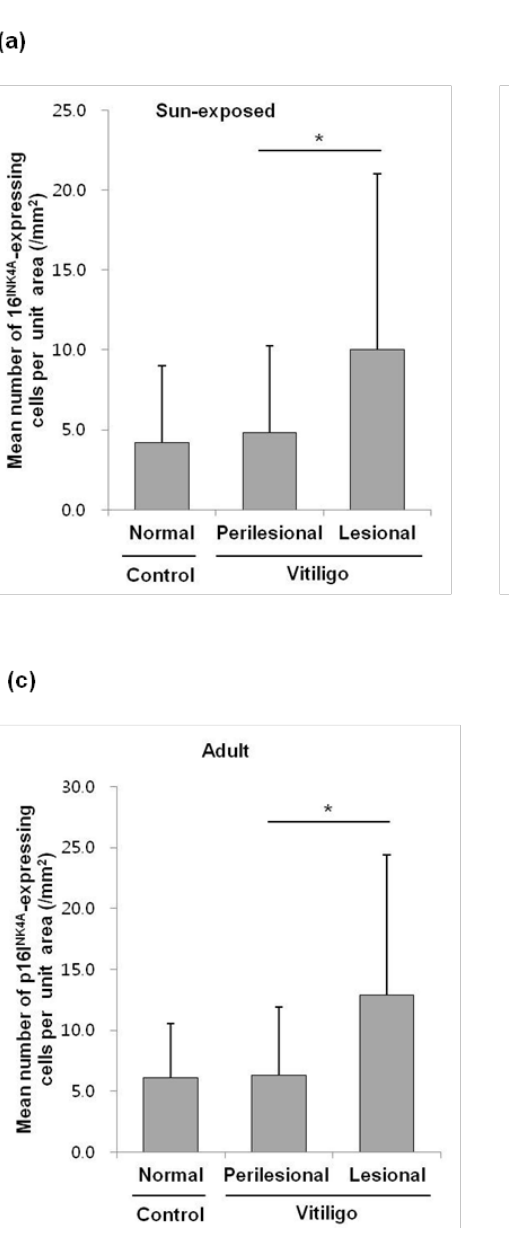
Figure 3. Subgroup analysis of the sun-exposed/non-exposed and the adult/young groups, quantified according to the measured dermal area (/mm 2 ) of each skin specimen: ( a ) results from the sun-exposed subgroups; data are shown as the mean ± SE, n = 43 patients with NSV, n = 27 normal controls; * p = 0.0007 from paired Student’s t -tests. ( b ) Results from the non-exposed subgroups; data are shown as the mean ± SE, n = 11 patients with NSV, n = 6 normal controls; p > 0.05 from a Mann–Whitney test and a Wilcoxon signed-rank test. ( c ) Results from the adult subgroups; data are shown as the mean ± SE, n = 32 patients with NSV, n = 20 normal controls; * p = 0.0006 from paired Student’s t -tests. ( d ) Results from the young subgroups; data are shown as the mean ± SE, n = 22 patients with NSV, n = 13 normal controls; p > 0.05 from a Mann–Whitney test and a Wilcoxon signed-rank test.